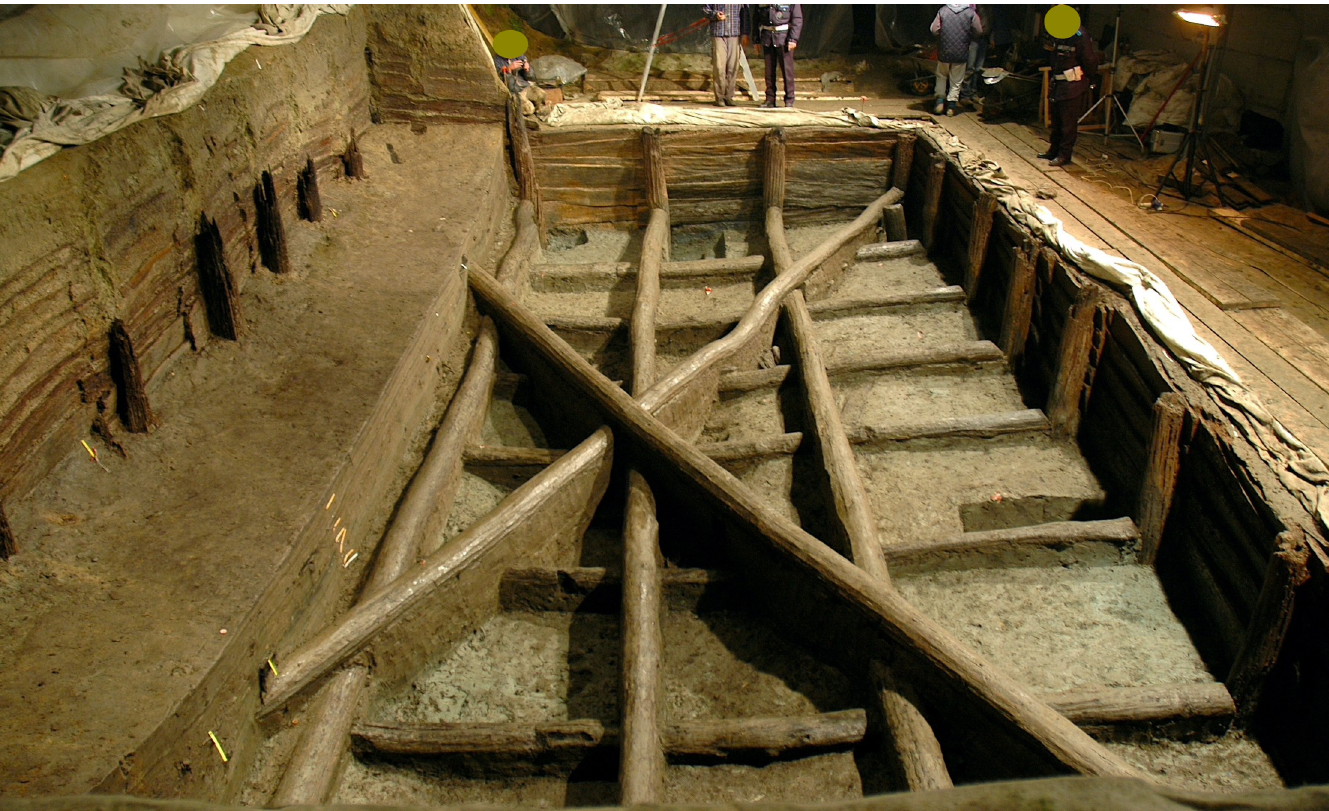
Fig 4. The upper tank at Noceto during the